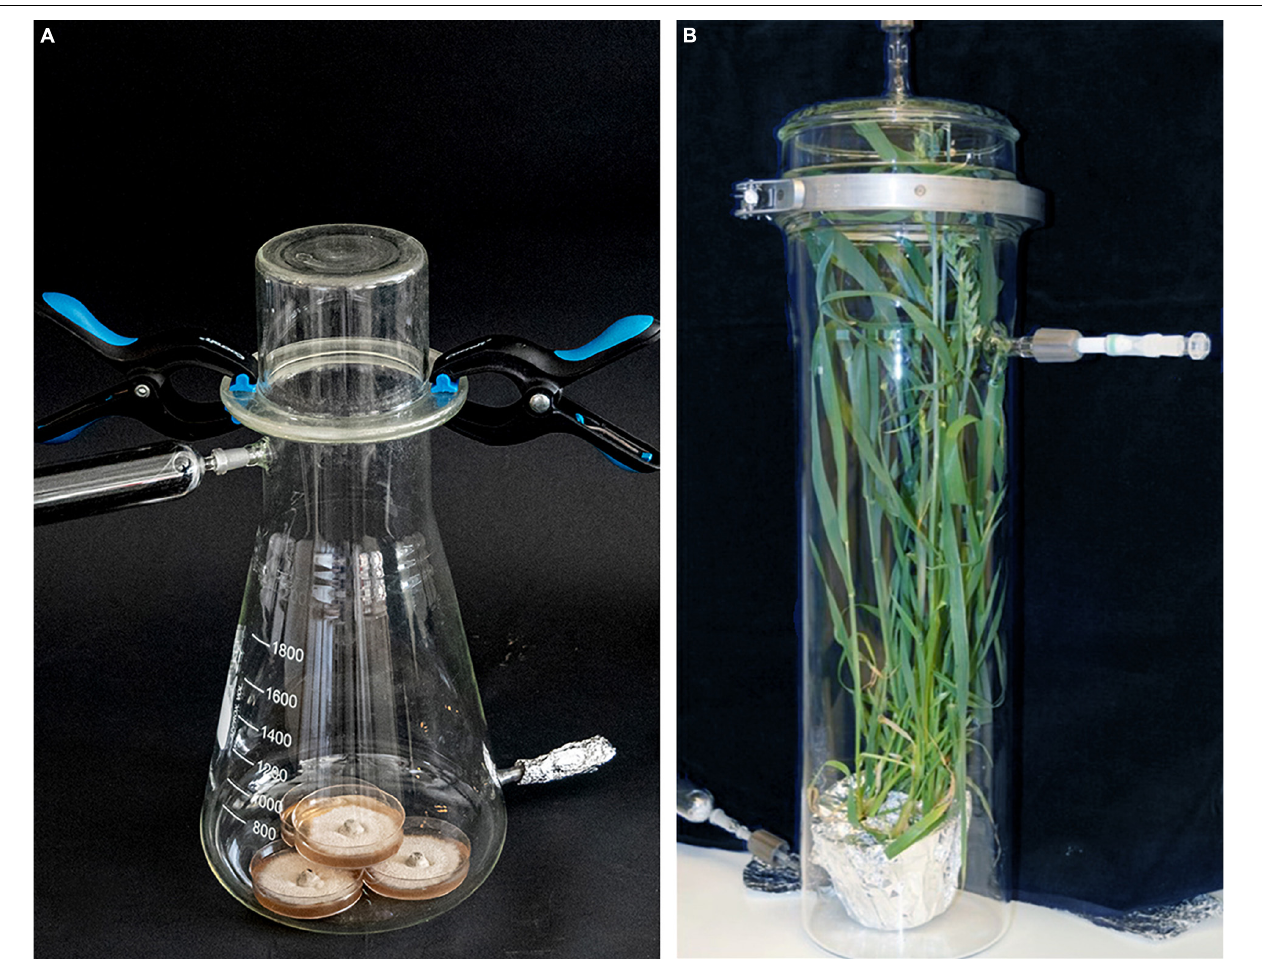
FIGURE 1 | Collection of volatile organic compounds from one fungal isolate on four potato dextrose agar (PDA) plates (5-cm diameter) (A) and from whole wheat plants in an airtight glass container (B) . Coal-filtered air is pushed through the glass chamber across the fungal mycelium or the plant surface at 220–240 ml/min, and volatile organic compounds contained in the air flow are collected on Super-Q filter at the other side of the